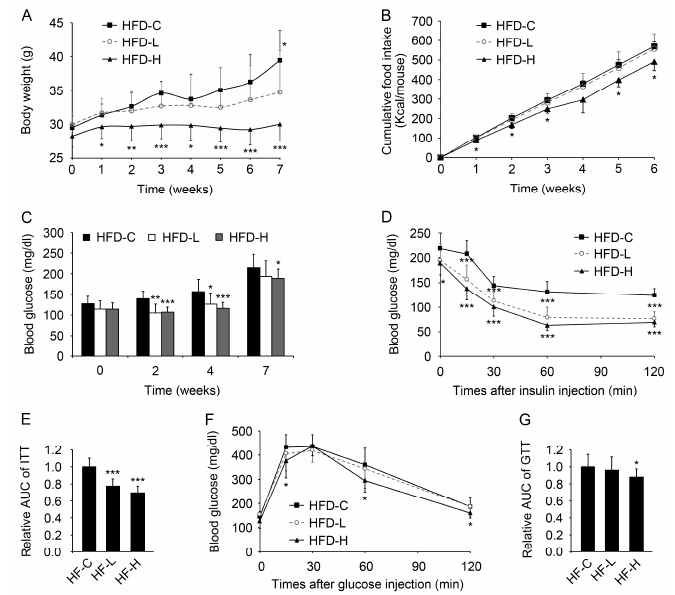
Figure 3. Hemin decreases body weight, energy intake, blood glucose and improves insulin and glucose tolerance in mice fed a high-fat diet (HFD). ( A ) The effect of hemin on body weight of mice fed HFD. Mice were fed HFD (HFD-C) or HFD supplemented with hemin at the low (HFD-L) or high dose (HFD-H); ( B ) The effect of hemin on total energy intake of mice fed HFD; ( C ) The effect of hemin on fasting blood glucose of mice fed HFD; ( D , E ) The effect of hemin on insulin tolerance of mice fed HFD for 7 weeks. ITT, insulin tolerance test; ( F , G ) The effect of hemin on glucose tolerance of mice fed HFD for 8 weeks. GTT, glucose tolerance test. * p < 0.05; ** p < 0.01; *** p < 0.001 versus HFD-C. n = 10 for each group in the above mouse studies.